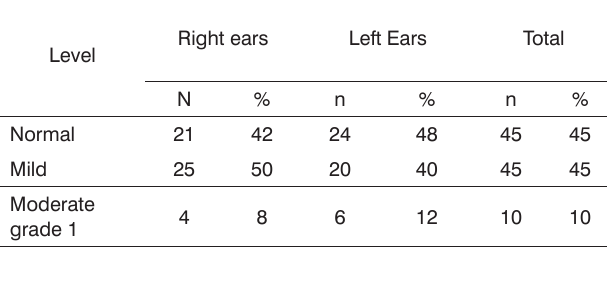
Table 7. Audiometric test results for right and left ears; patients in the control group (DM-free subjects) according to hearing loss level - BIAP 25